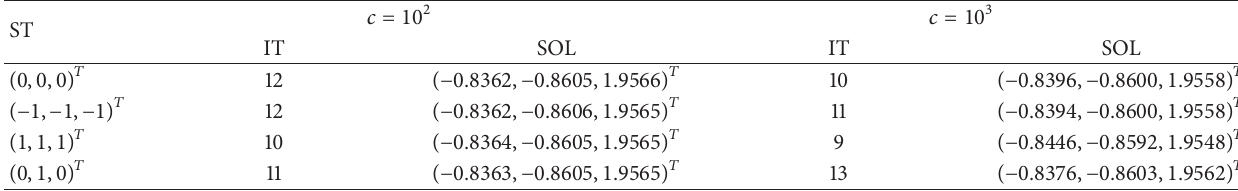
Table 2: Numerical results for Example 2 󸀠 .